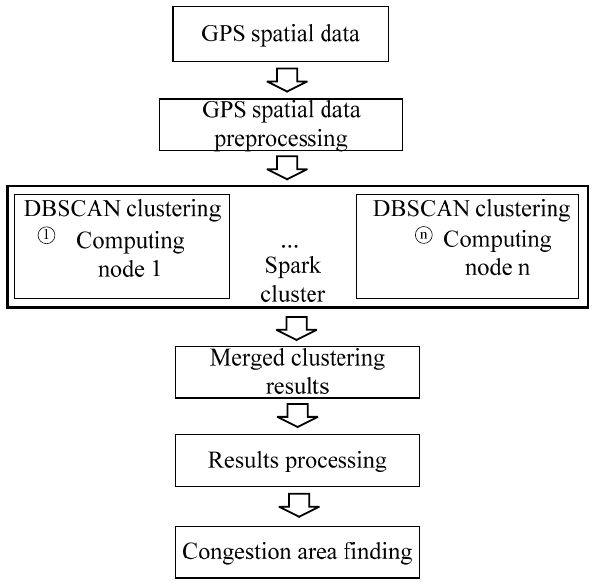
Figure 23. Entire process of the congested area discovery with GPS trajectory data.